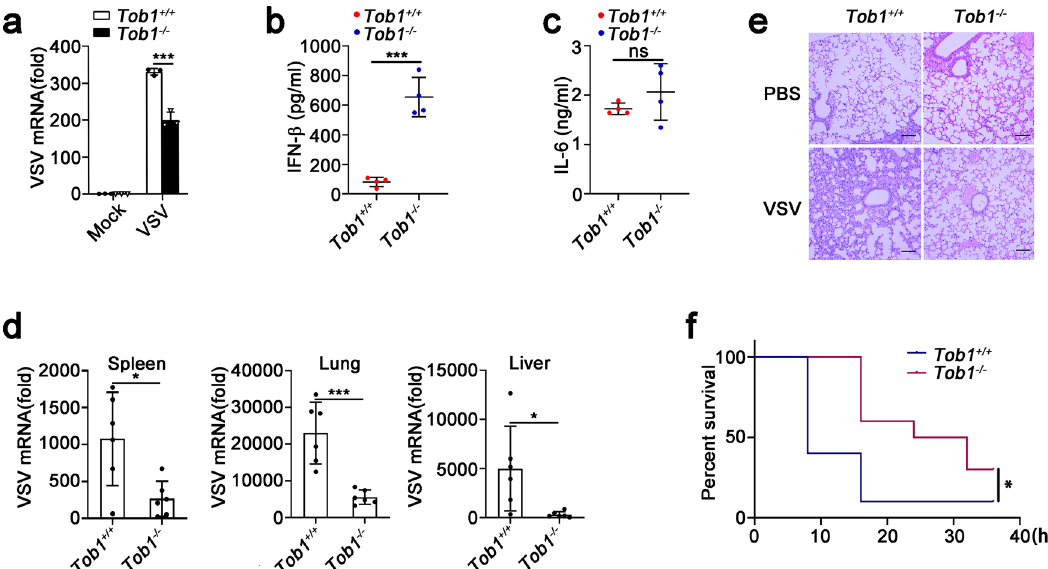
Fig. 3 TOB1 de fi ciency enhance innate immune responses against VSV in vivo. a Quantitative real-time RT-PCR analysis of VSV mRNA expression in peritoneal macrophages (PMs) isolated from Tob1 + / + or Tob1 − / − mice and then infected with VSV for 8 h. b , c Tob1 + / + or Tob1 − / − mice ( n = 4) were infected with VSV (4 × 10 7 pfu/mouse) for 8 h. ELISA of IFN- β ( b ) and IL-6 ( c ) in serum. d Tob1 + / + or Tob1 − / − mice ( n = 6) were infected with VSV (4 × 10 7 pfu/mouse) for 12 h. Quantitative real-time RT-PCR analysis of VSV mRNA in spleen, lung, and liver. e Hematoxylin and eosin staining of lung tissue sections with VSV (4 × 10 7 pfu/mouse) infection for 18 h (PBS, n = 3 and VSV, n = 3 per condition). Scale bar, 100 μ M. f Kaplan – Meier method was used to evaluate the survival curves ( n = 10 per condition). All data are shown as the means ± SD. Signi fi cance was determined by unpaired two-tailed